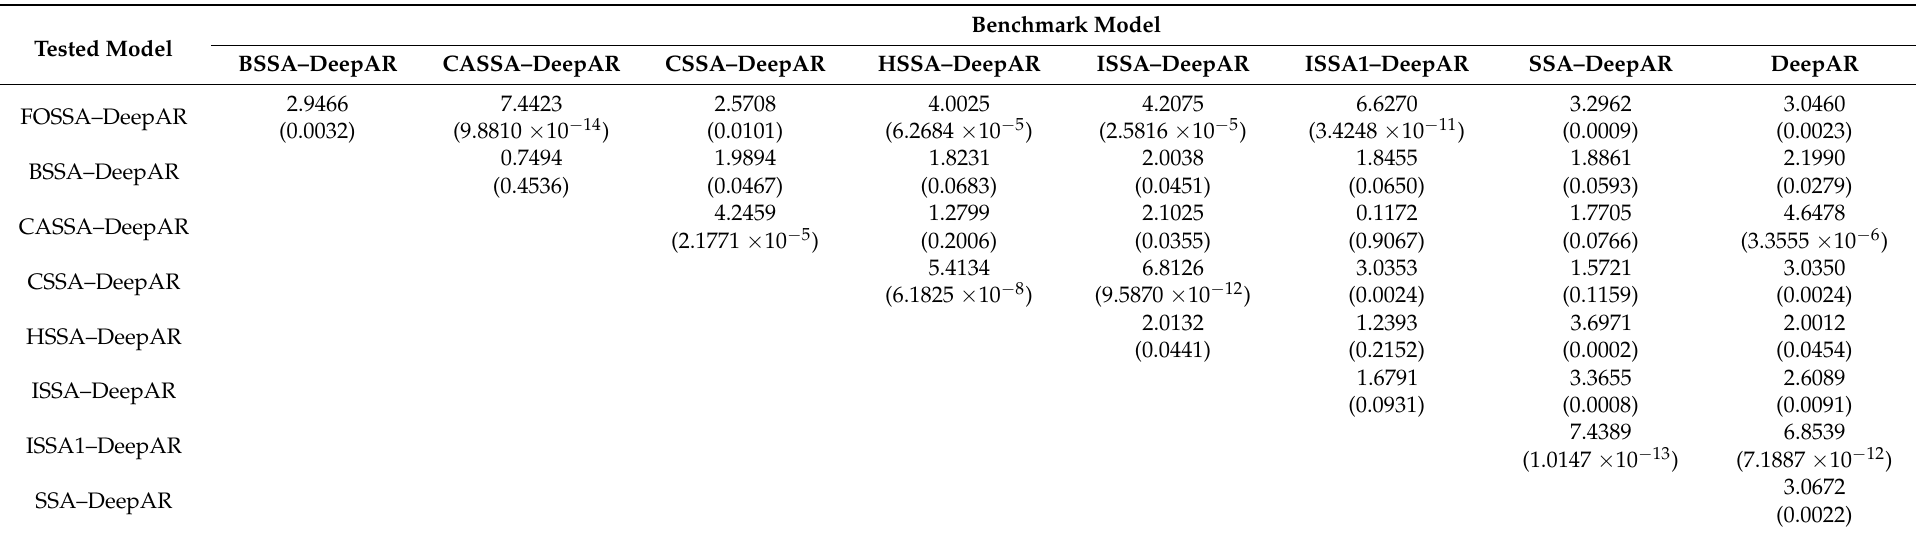
Table 5. DM test results of PM2.5 concentration point forecasting results in